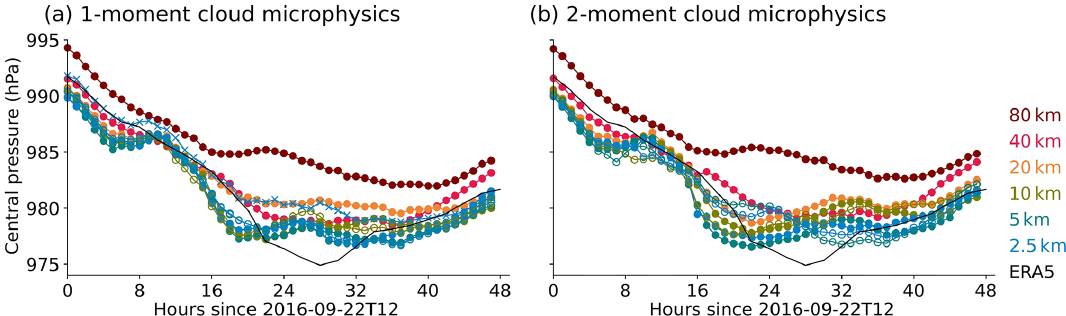
Figure 9. Central pressure of cyclone Vladiana from 22 September 2016 at 12:00 for (a) one- and (b) two-moment cloud microphysics. Filled and empty markers distinguish simulations with parameterized and explicit convection. In panel (a) , the blue line with crossed markers shows the 2.5km simulation regridded to 80km. The central pressure derived from ERA5 is shown as the thin black line.